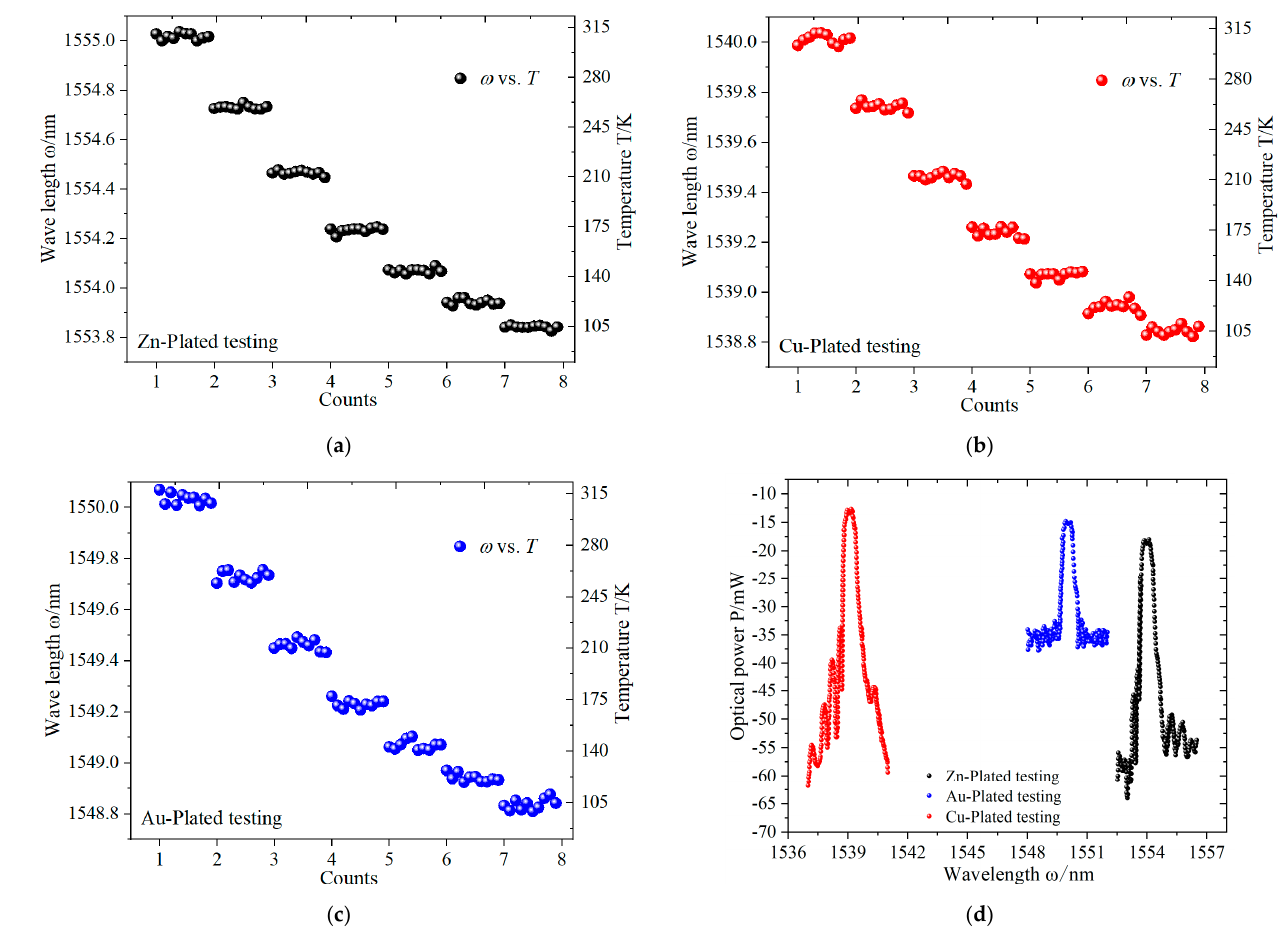
Figure 5. The relationship between wavelength, temperature, and optical power under different packaging materials: ( a ) zinc packaging material fiber testing; ( b ) copper packaging material fiber testing; ( c ) gold packaging material fiber testing; ( d ) wavelength vs. optical power in different packaging materials.